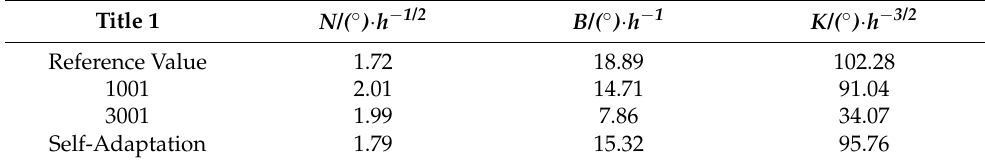
Table 3. Noise coefficients on different window